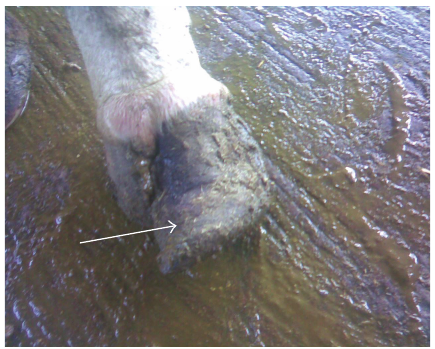
Figure 9: Overgrown hoof.